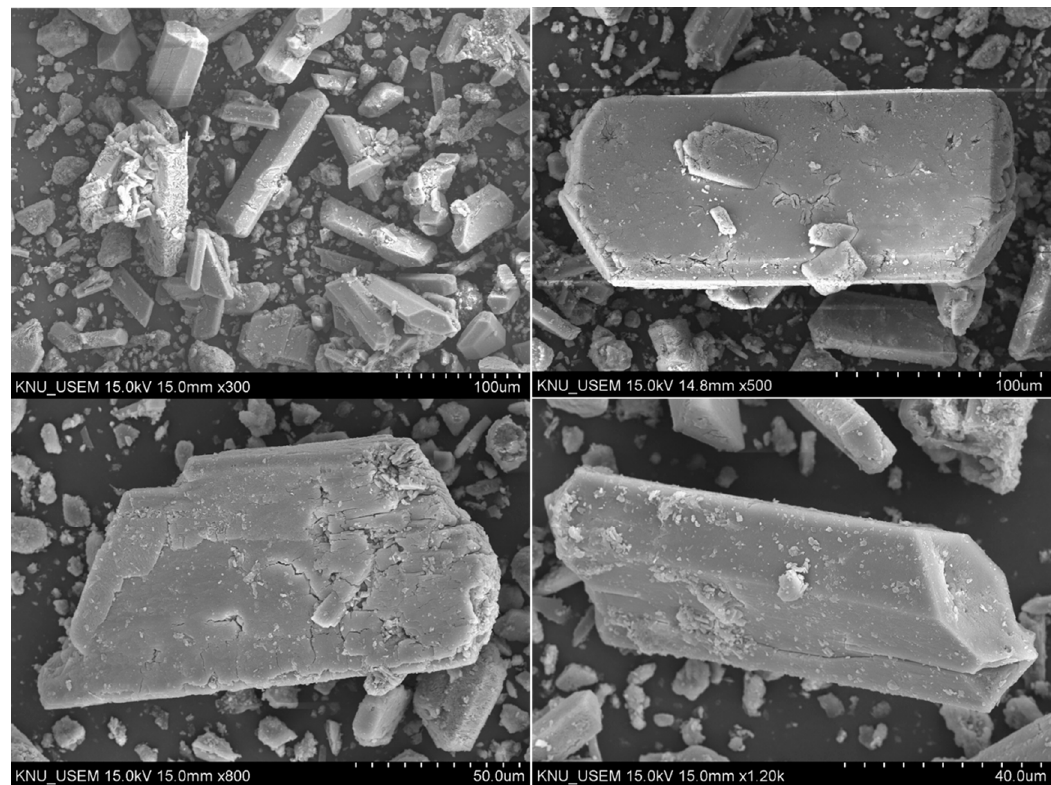
Figure 4. Scanning electron micrograph (SEM) of the recovered material.